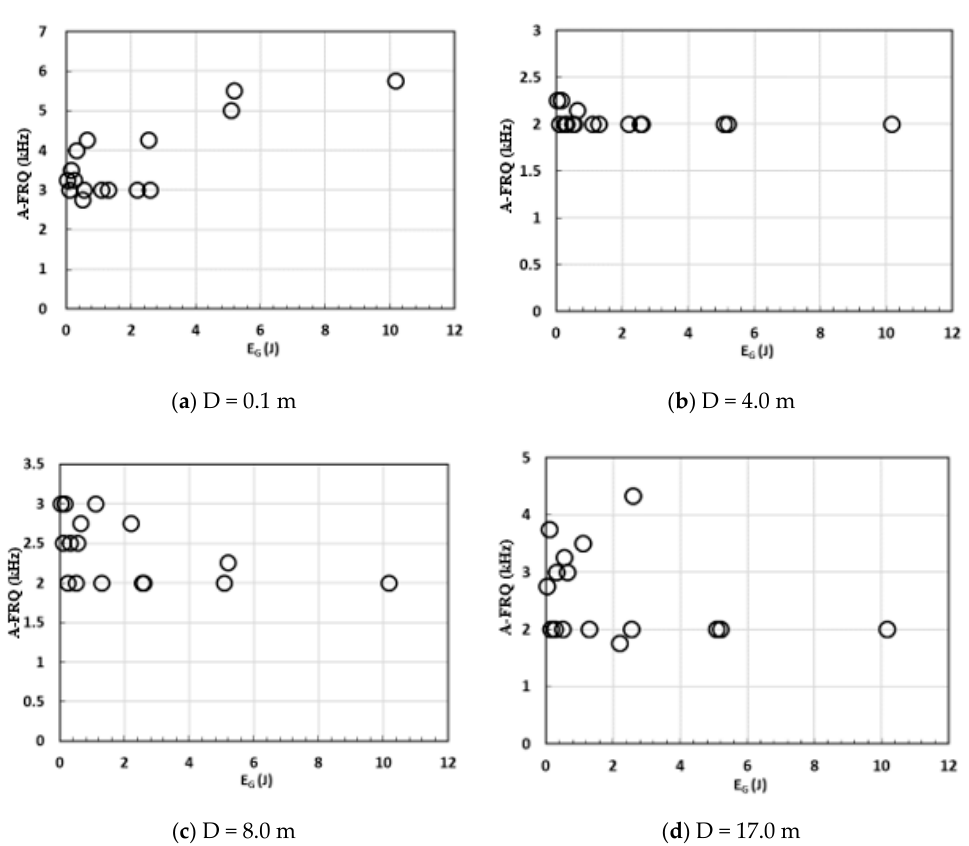
Figure 11. Average frequency according to impact energy.